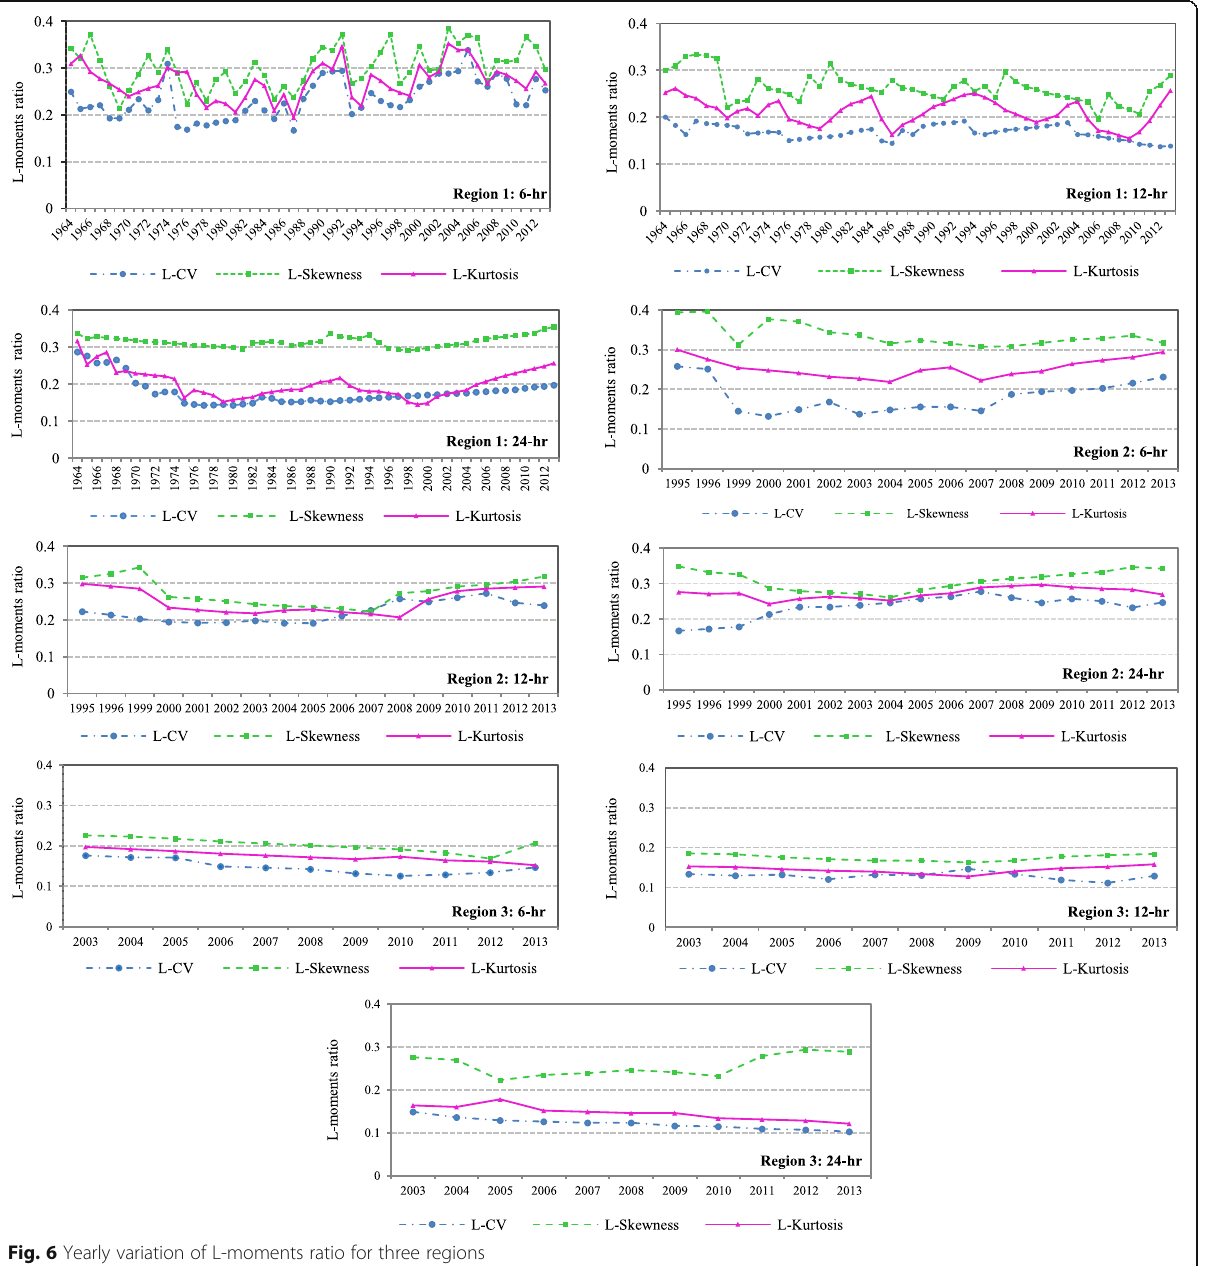
Fig. 6 Yearly variation of L-moments ratio for three regions